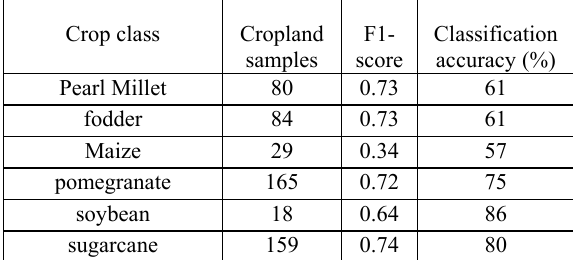
Table 2. F1-Scores and classification accuracy of crop type map